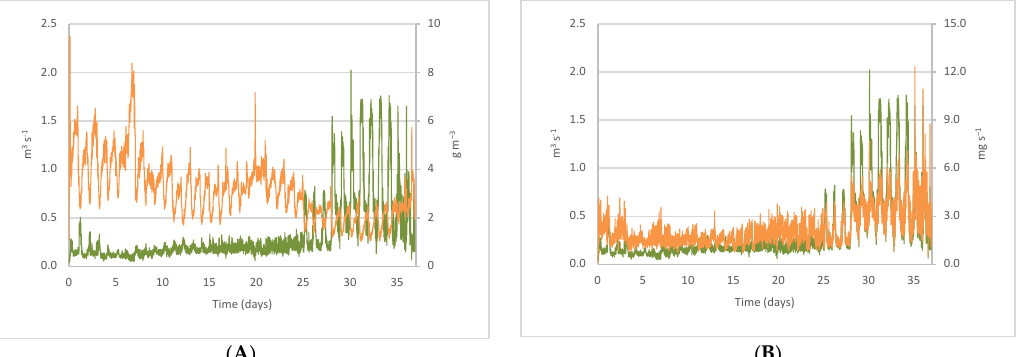
Figure 4. Evolution of ventilation flow, – Q (m 3 s − 1 ) during the cycle, with (A) concentration of CO 2 , – C CO2 (g m − 3 ), and (B) emission of CO 2 per animal, – E CO2 (mg s − 1 ).